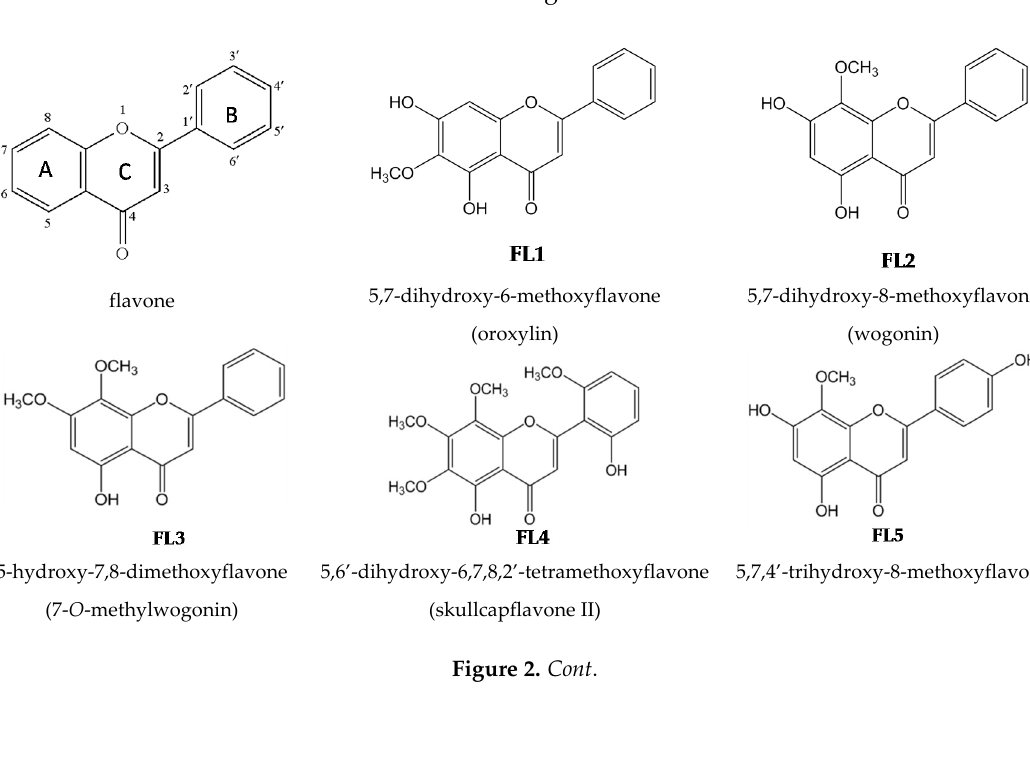
Figure 2. Structures of flavones isolated from Scutellariae radix .